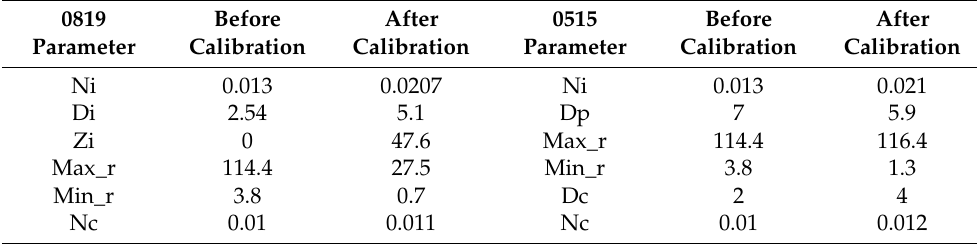
Table 5. Values set before and after parameter